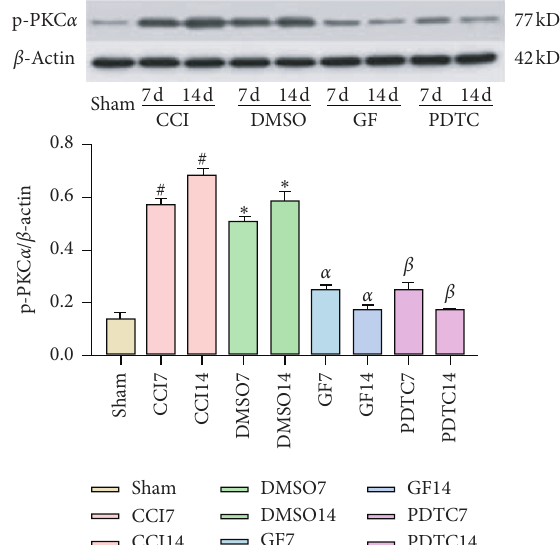
Figure 2: Inhibiting PKC or NF- κ B reduced CCI-induced p-PKC α overexpression in DRGs. Data are expressed as mean ± SD and analyzed with one-way ANOVA tests and the S-N-Q test. # P < 0 . 05, ∗ P < 0 . 05 vs. Sham group, α P < 0 . 05, β P < 0 . 05 vs. CCI group, α P < 0 . 05 vs. DMSO group.